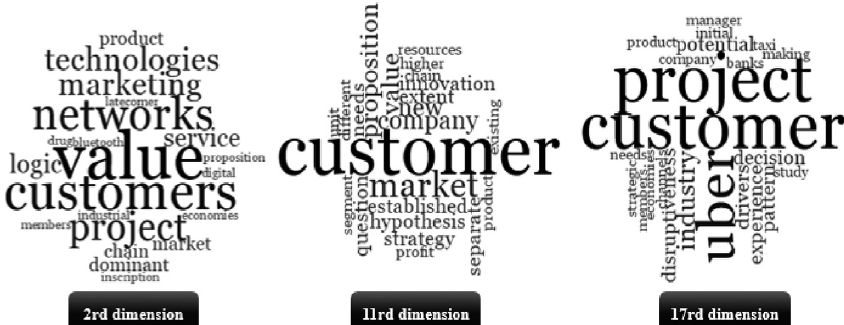
Figure 9. The 2nd, 11th